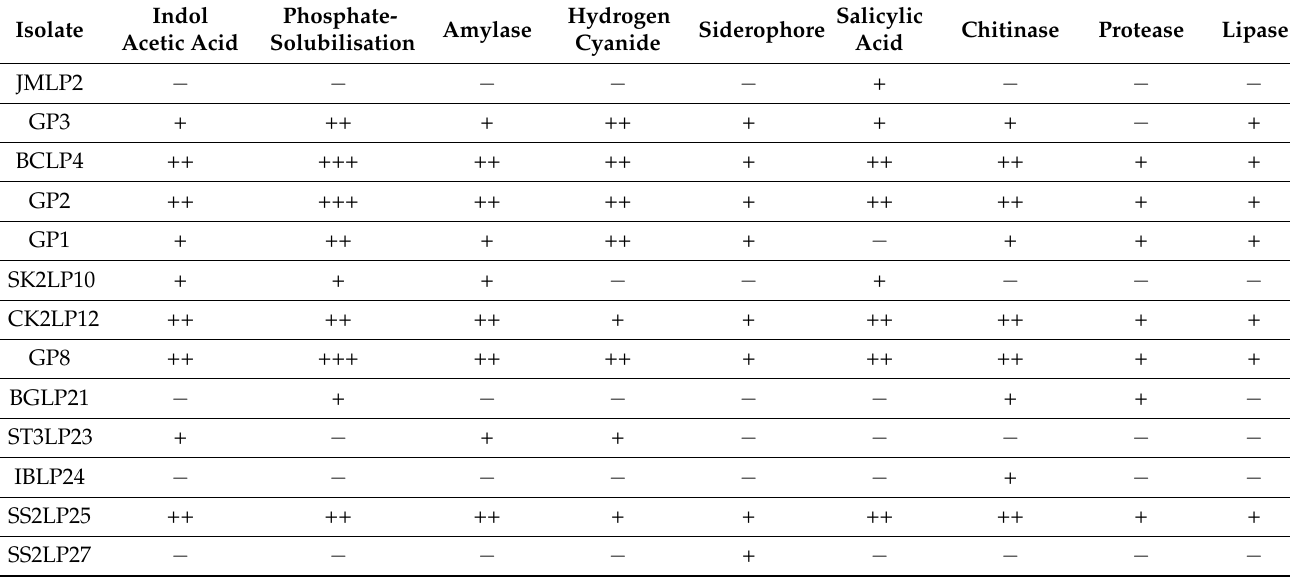
Table 5. The biochemical and enzymatic assay of native acid-tolerant Pseudomonads and related isolates.